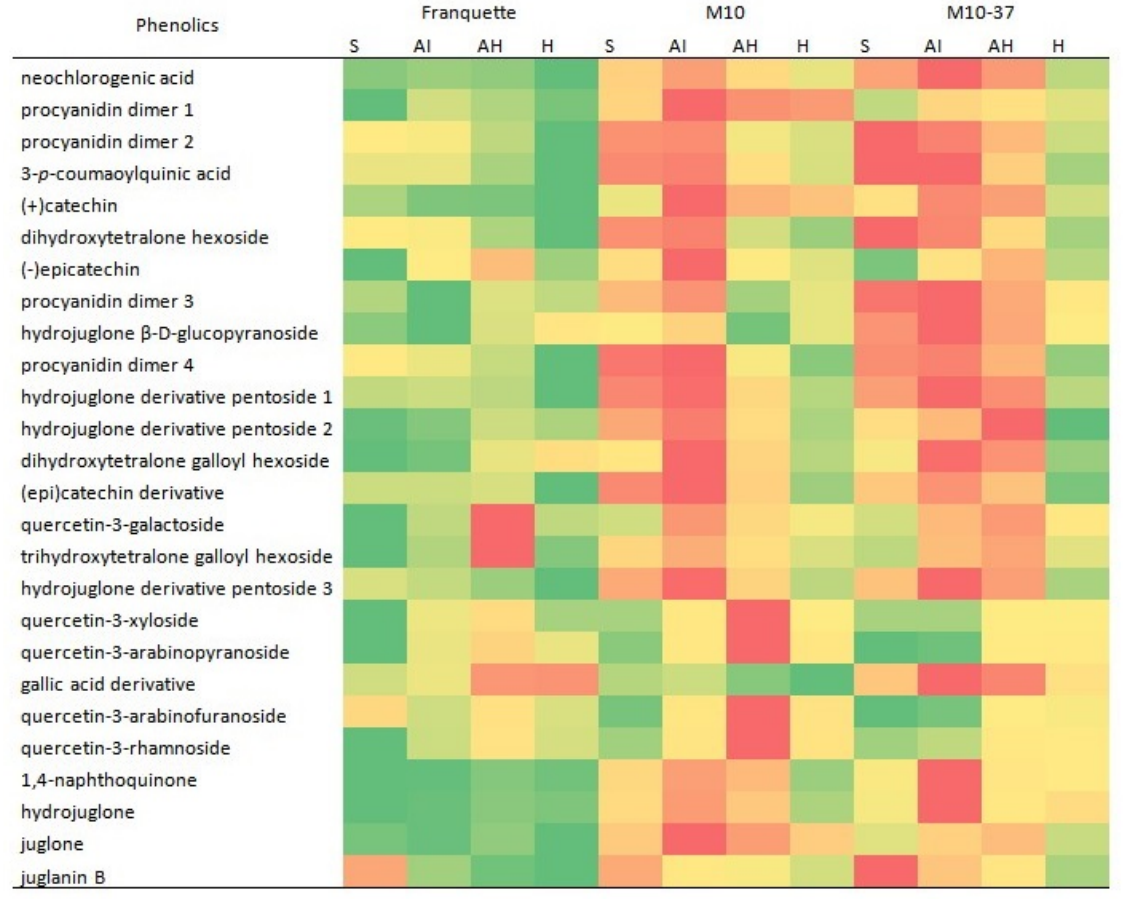
Figure 4. Heat map showing relative content of the phenolic compound identified between cultivars from highest to lowest content between columns. Red: highest concentration; green: lowest concentration. S: inner spot of infected tissue; AI: outer margin of infected tissue; AH: healthy tissue surrounding the infection; H: healthy tissue.